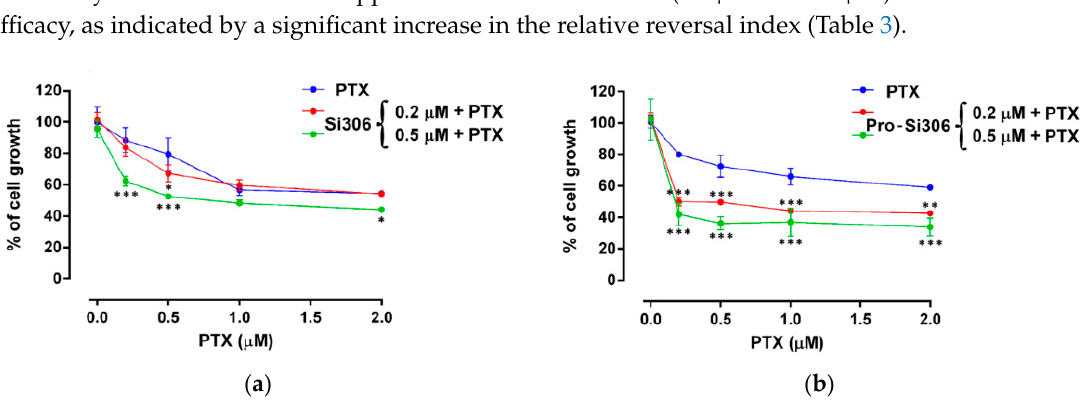
Figure 4. c-Src inhibitors enhance the sensitivity of U87-TxR cells to paclitaxel (PTX). The effects of simultaneous combinations of Si306 ( a ) and pro-Si306 ( b ) with PTX on U87-TxR cell growth inhibition were assessed by 3-(4,5-dimethylthiazol-2-yl)-2,5-diphenyltetrazolium bromide (MTT) assay; values are expressed as mean ± S.D. ( n = 3). The significant difference to untreated control is shown as: *, p < 0.05; **, p < 0.01; ***, p < 0.001. Table 3. Relative reversal of PTX resistance in U87-TxR cells induced by Si306 and pro-Si306.